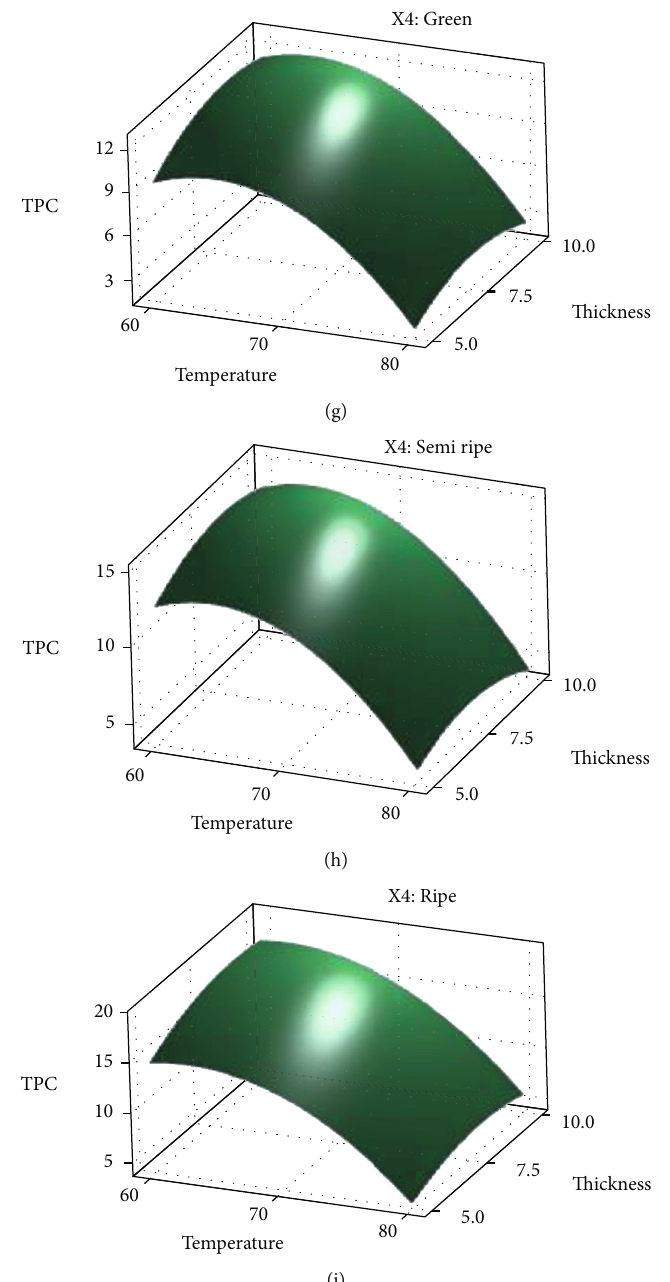
Figure 2: Surface plots of TPC as a function of time, temperature, and thickness for green, semiripe, and ripe papaya